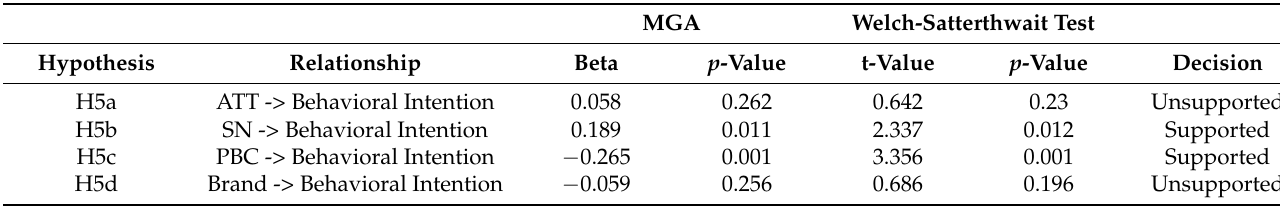
Table 6. Hypotheses testing for multigroup